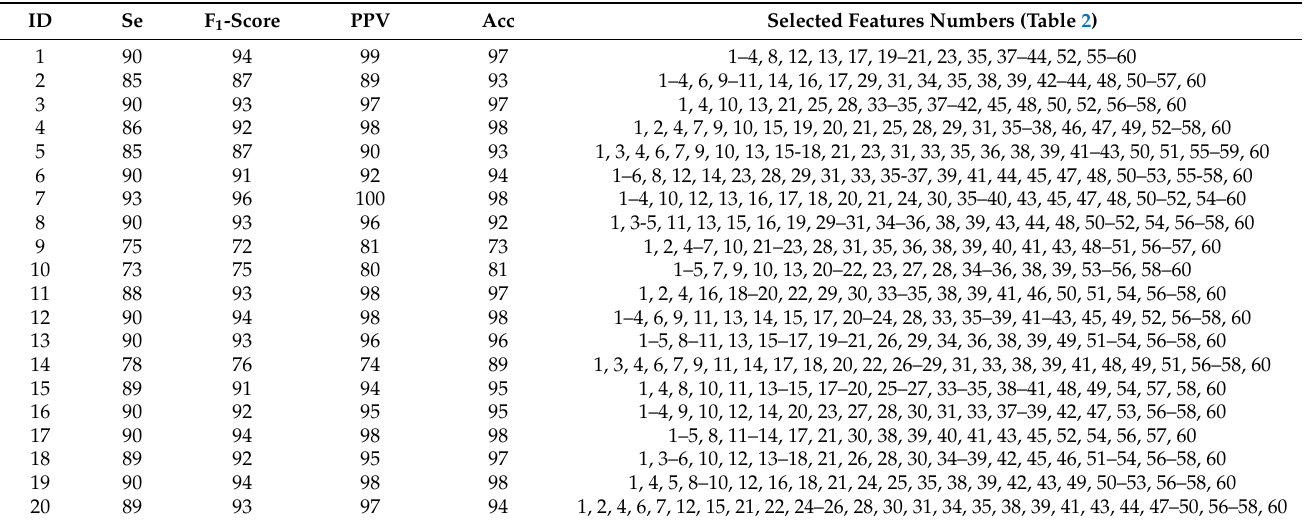
Table 6. Classification performance of the Stack method on the individual subjects. The selected features using the PSO algorithm are also reported in the last column. These results correspond to the S = 6 s with O = 3